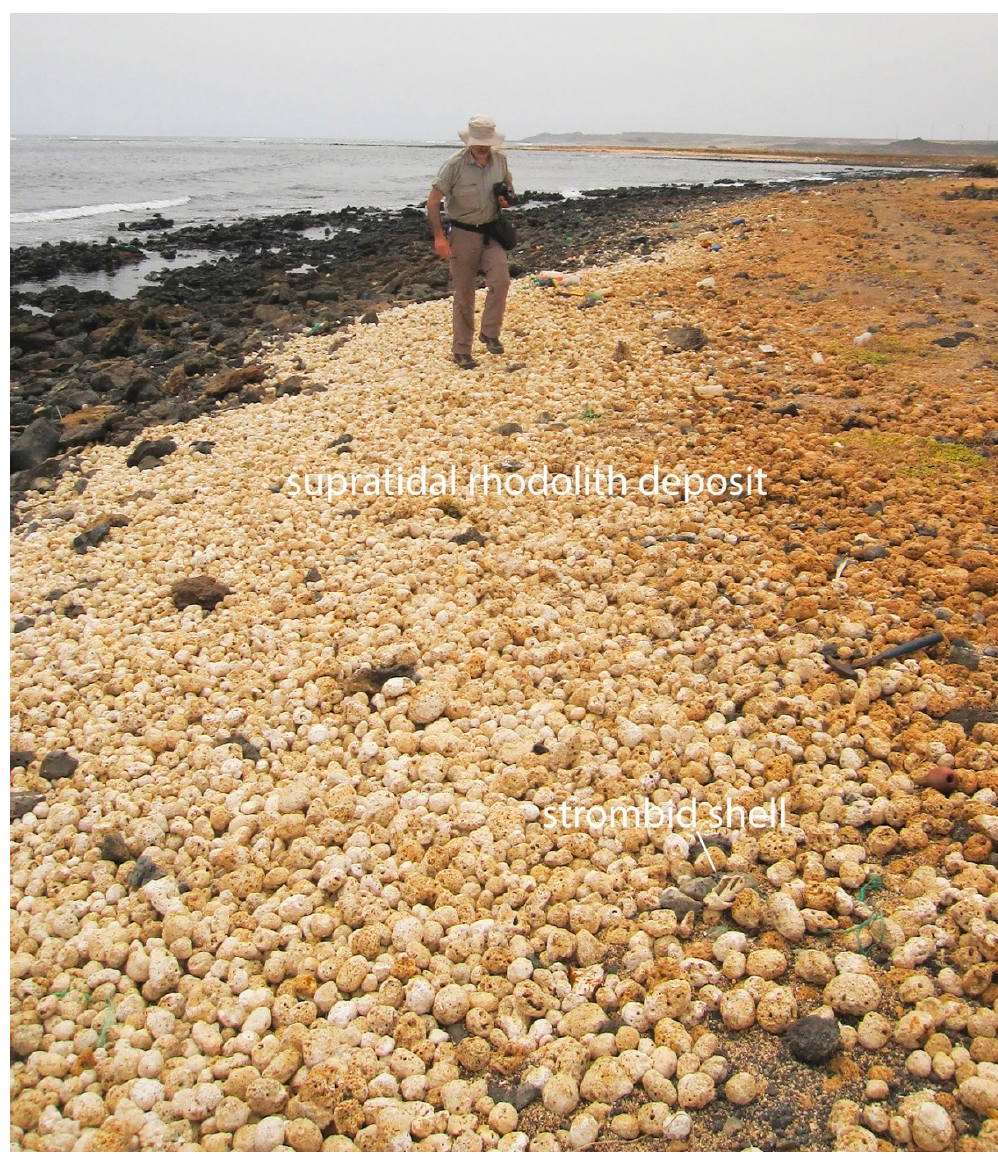
Figure 5. Holocene supratidal rhodolith deposit at Praia das Gatas north of Baía da Parda on Sal Island (figure and rock hammer for scale). (figure and rock hammer for